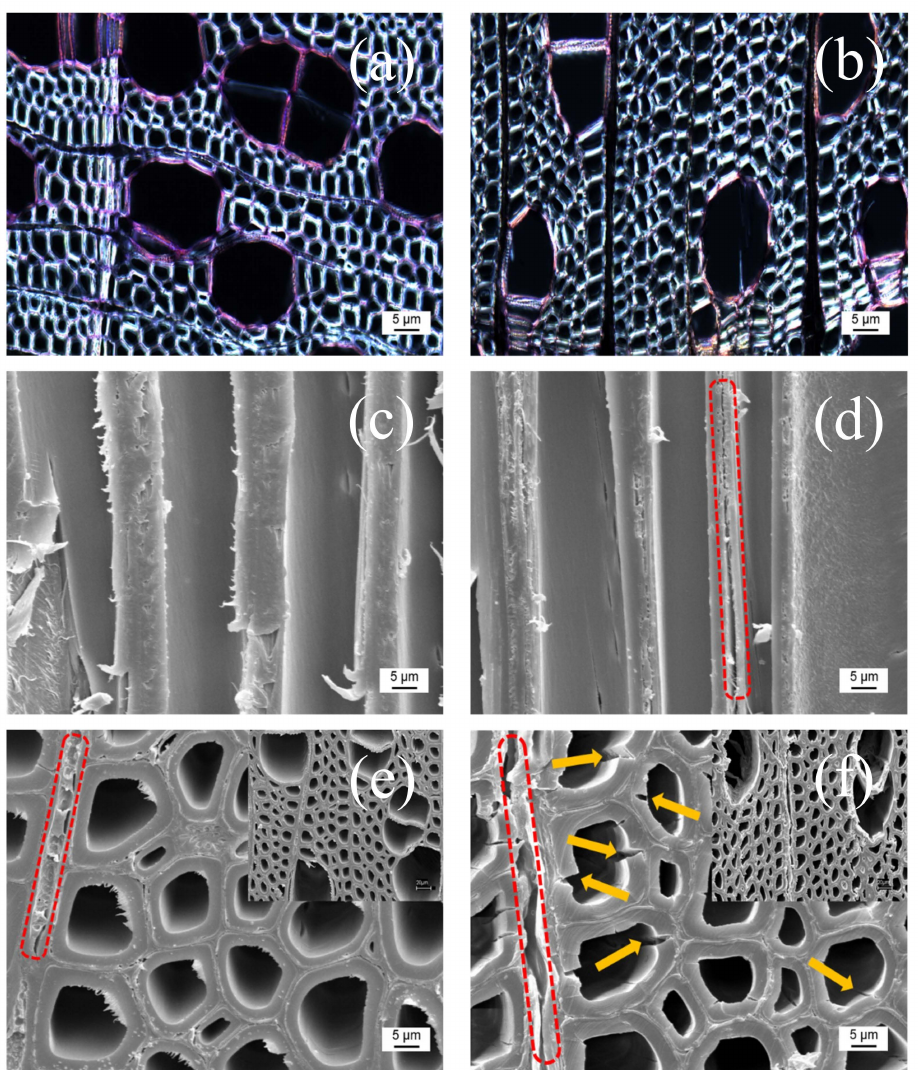
Figure 2. ( a , b ) Optical micrographs of the untreated and p -TsOH treated poplar wood in radial (R) direction (stained with Safranin O). ( c , d ) SEM images of the untreated and p -TsOH treated poplar wood in longitudinal (L) direction, where some cracks were seen in middle lamella (red dashed part). ( e , f ) SEM images of the untreated and p -TsOH treated poplar wood in radial (R) direction. Some pores or cracks were clearly seen in ray cell after p -TsOH treatment (red dashed part). Yellow arrows showed broken cell lumen after p -TsOH